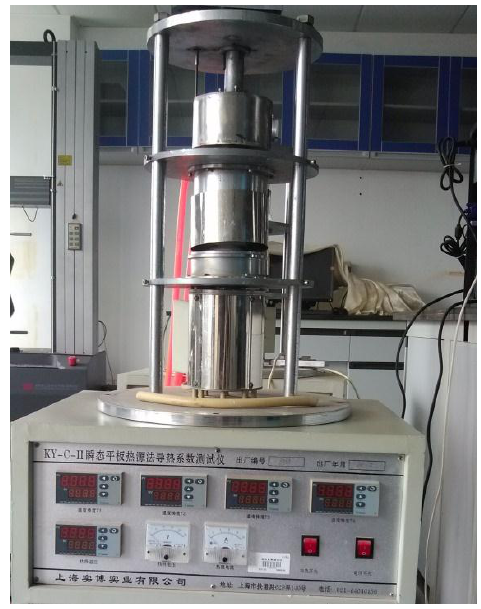
Figure 7. Thermal conductivity tester KY-C-II.